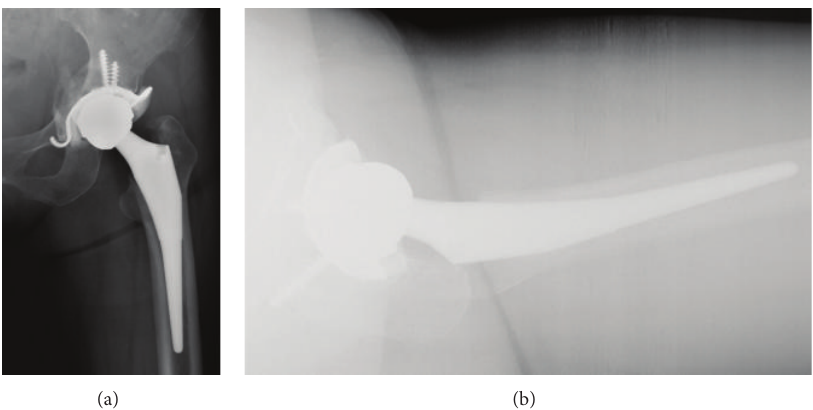
Figure3:Radiographstaken1yearaftertotalhiparthroplastyshowingwell-fixedcementlessfemoralstemandconsolidatedmedialacetabular bone graft with well-fixed acetabular cup ((a);